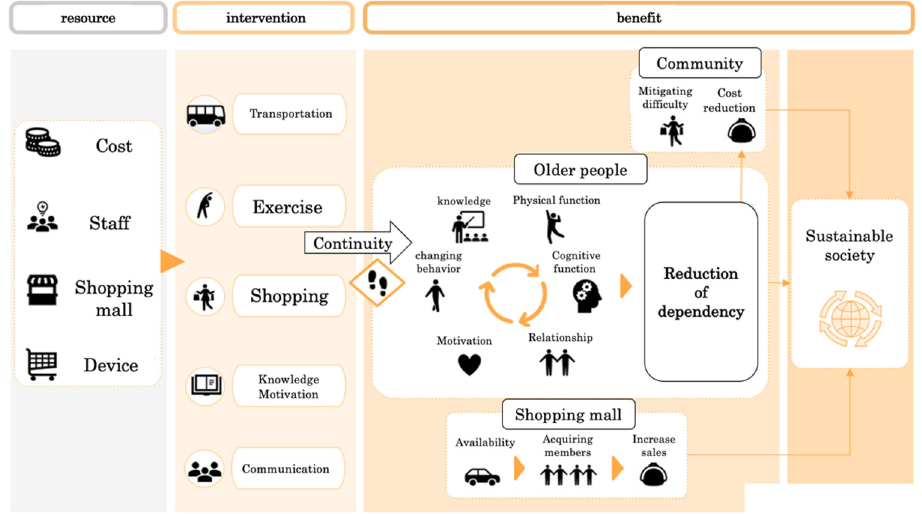
Figure 2. Logic model of shopping rehabilitation. Copyright © 2021 Hikari project Co., Ltd. All Rights Reserved.